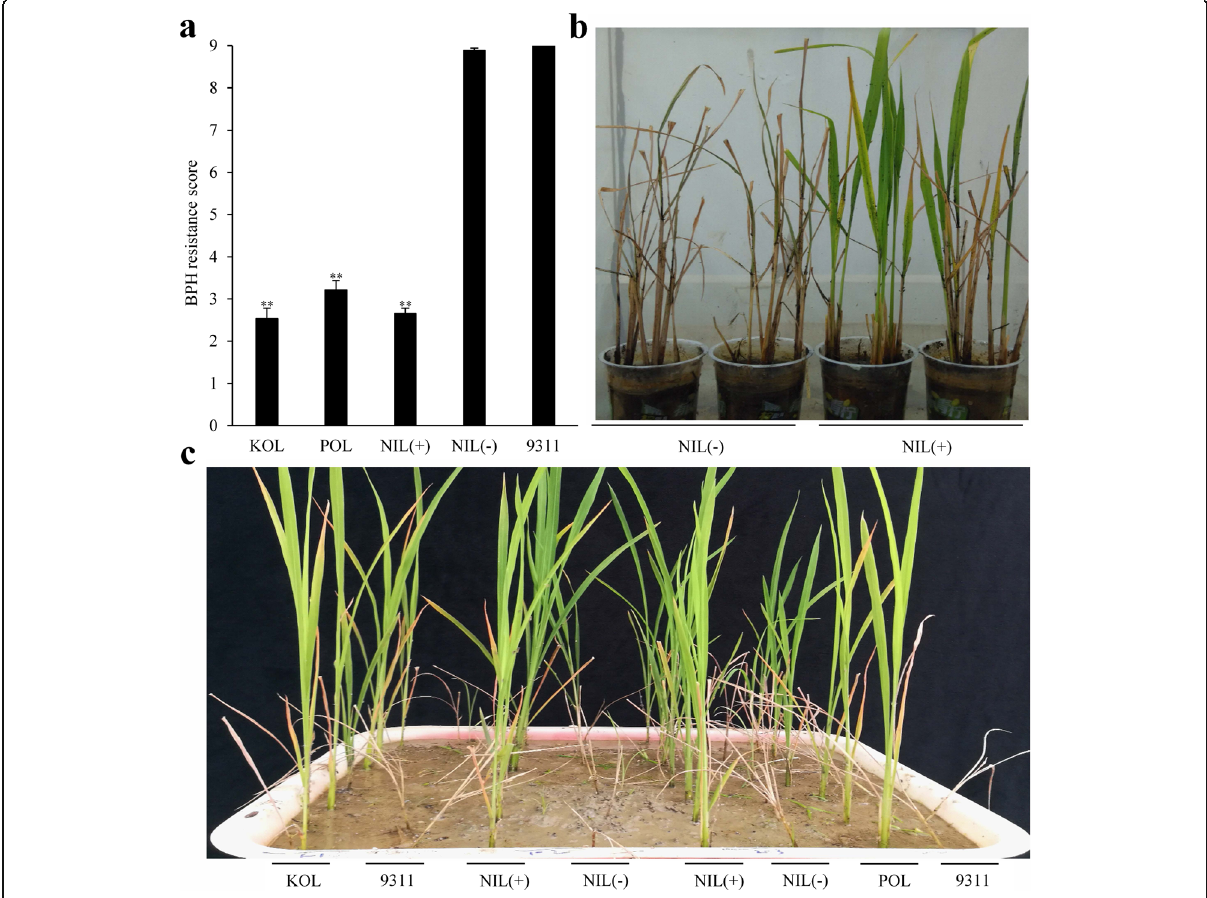
Fig. 5 Test of resistance effect of Bph33 at seedling stage and tillering stage. a Seedling resistance of NILs and parents. Asterisks indicate significant difference between the resistant and the susceptible genotypes at 0.01 level. Error bar indicates standard error. b NIL(+) and NIL( − ) plants at 15 DAI. c Seedlings of NILs and parents at 12